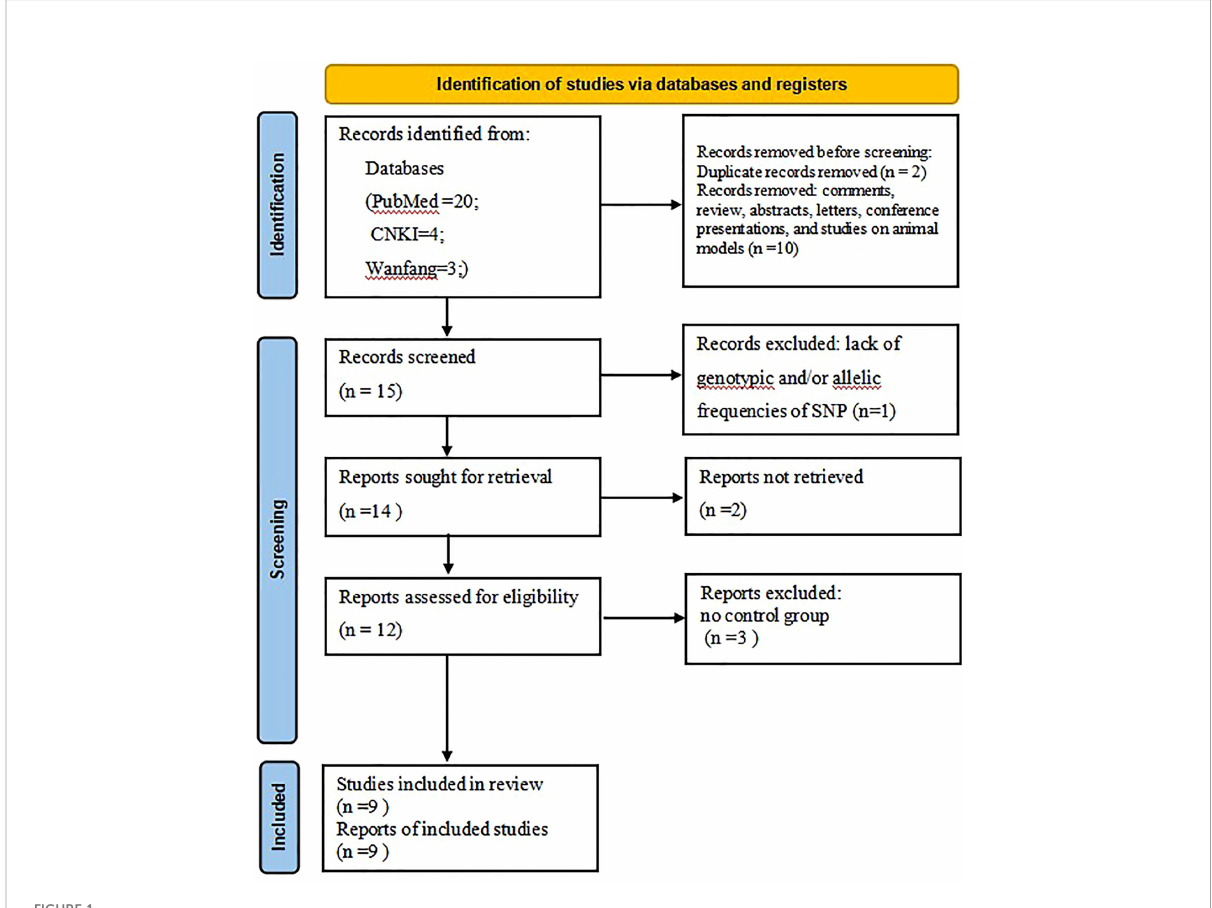
FIGURE 1 The Flow chart showing the study selection